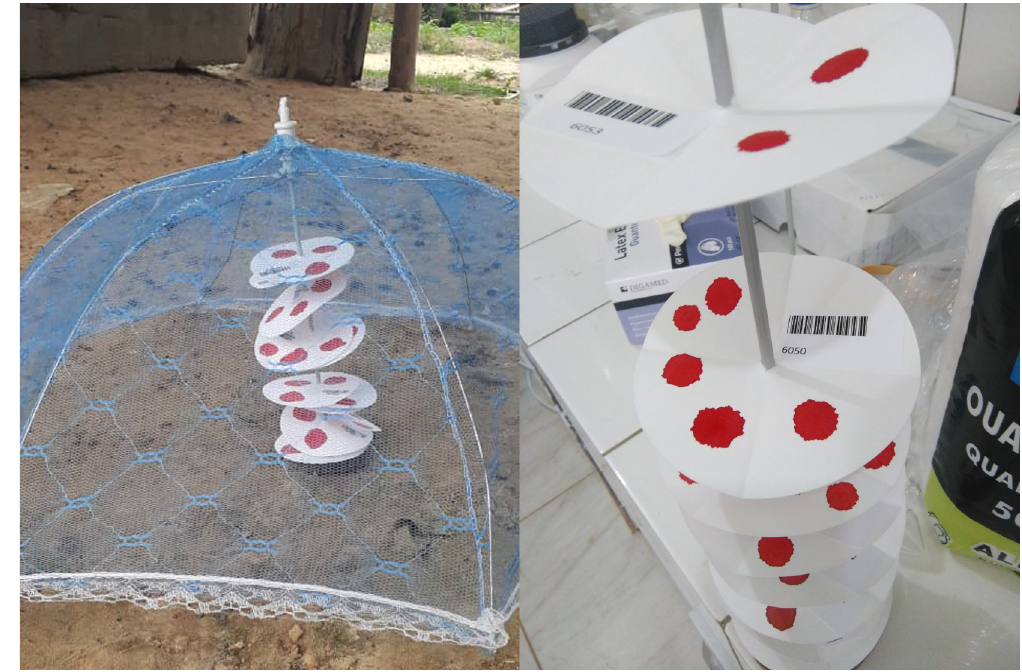
Fig 3. Drying of DBS samples on Filter Paper in the field, prior to transportation to the central